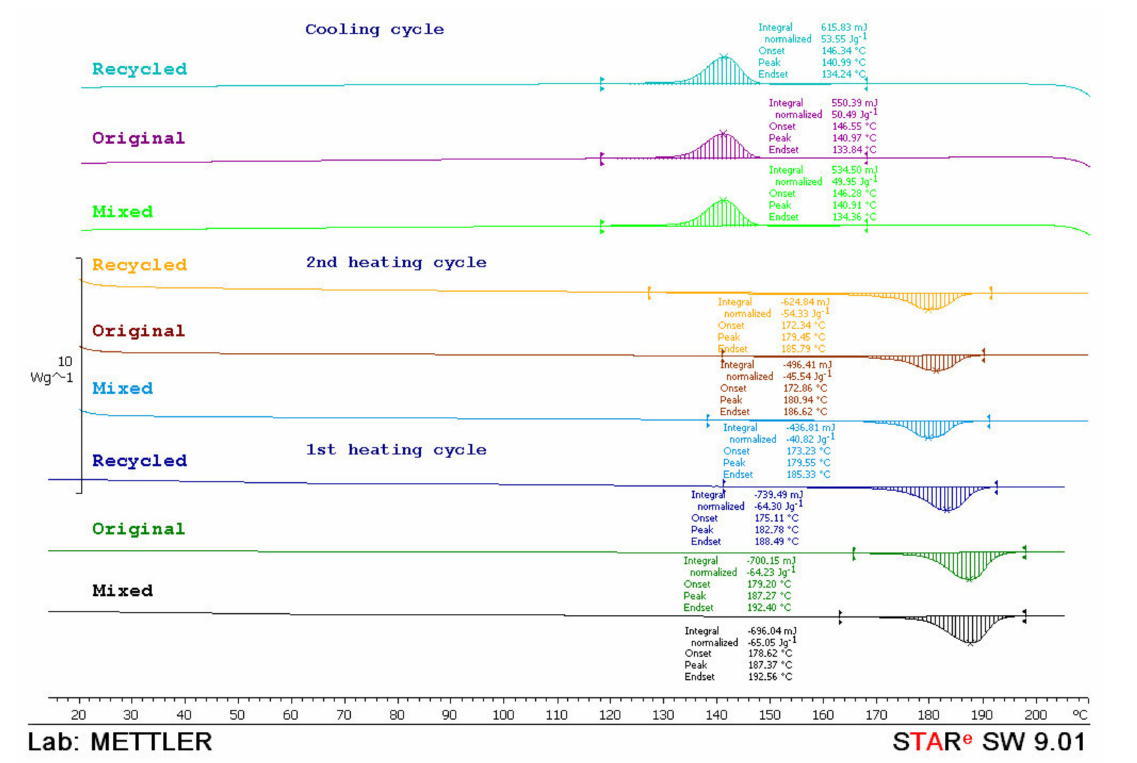
Figure 16. DSC thermograms of original, mixed and recycled polyamide after ageing in UV chamber 1000 h obtained during the first and second heating cycle and the cooling cycle.